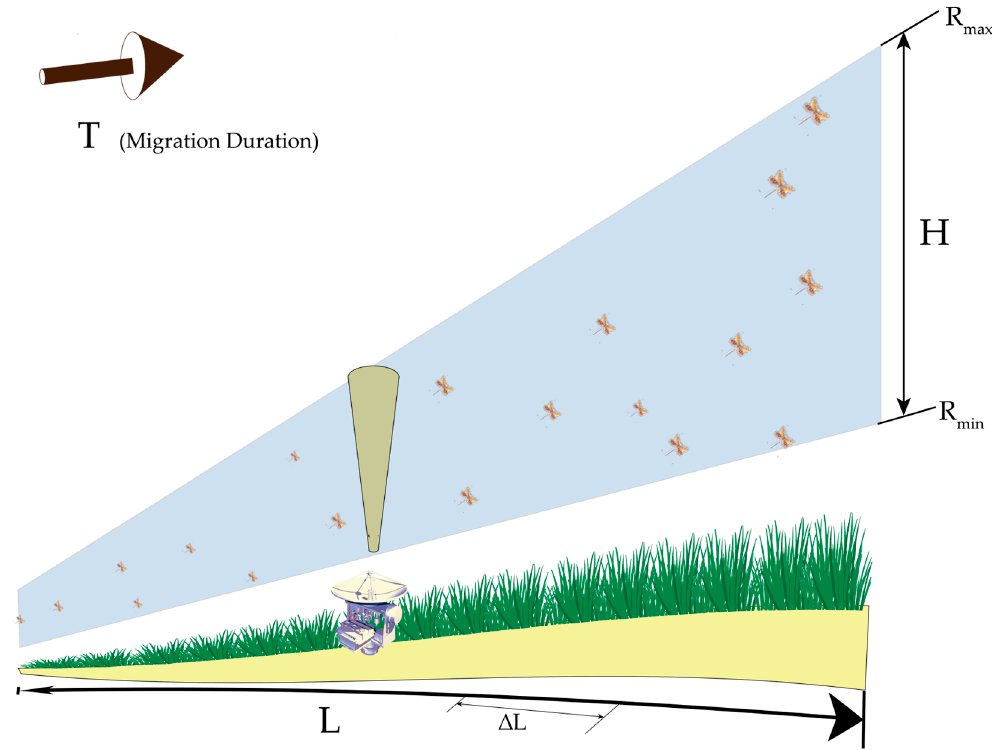
Figure 2. Schematic diagram of the biomass measurement on a larger geographical